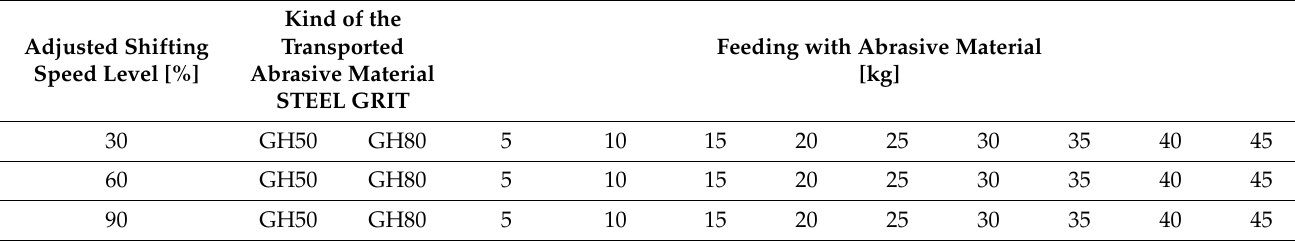
Adjusted Shifting Speed Level